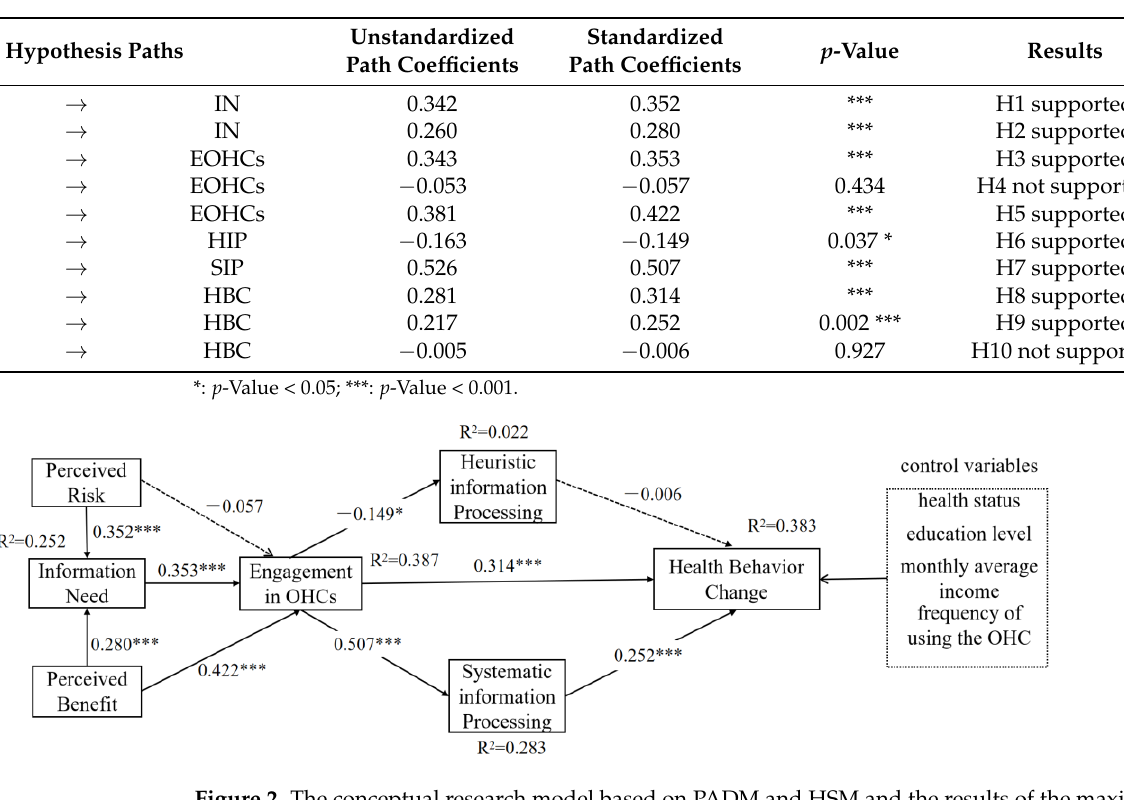
Figure 2. The conceptual research model based on PADM and HSM and the results of the maximum likelihood estimate. * p < 0.05; *** p < 0.001.